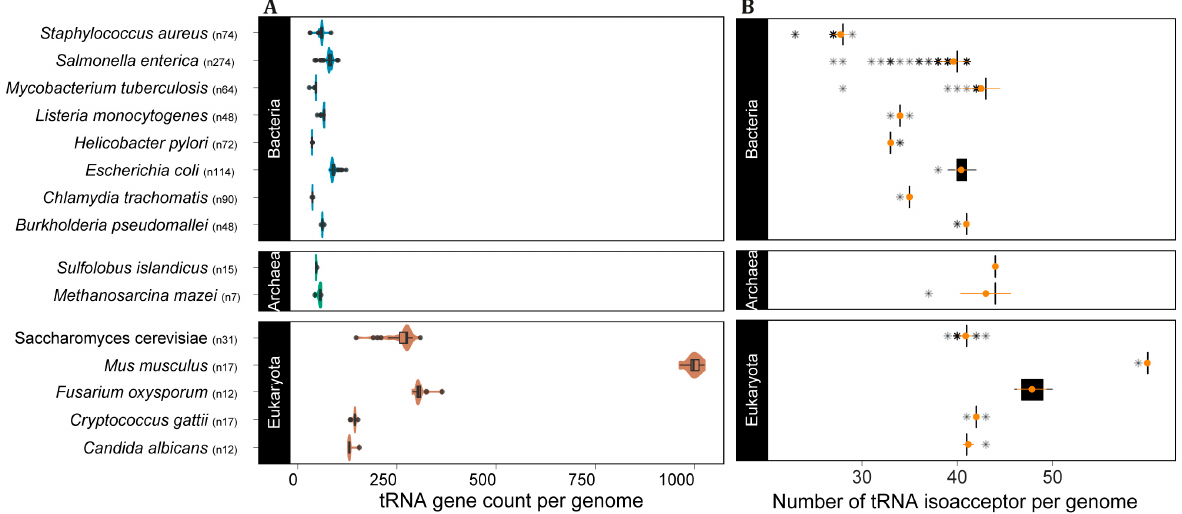
Figure 4. Intraspecific tRNA CNV affects tRNA anticodon repertoire in the three domains of cellular life. ( A ) Distribution of tRNA gene count per genome per species and ( B ) number of tRNA anticodons per genome per species, with mean and SD in orange, the asterisks represent the boxplot outliers. n = number of genomes per species.